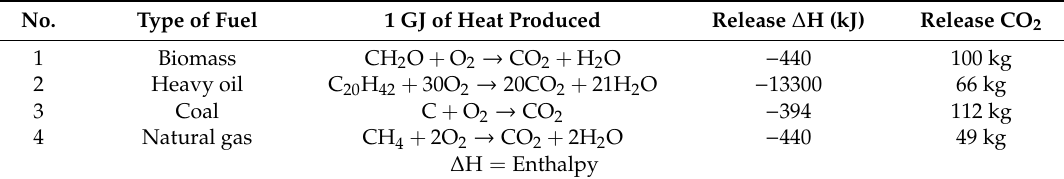
Table 3. The energy produced by various types of fuels.